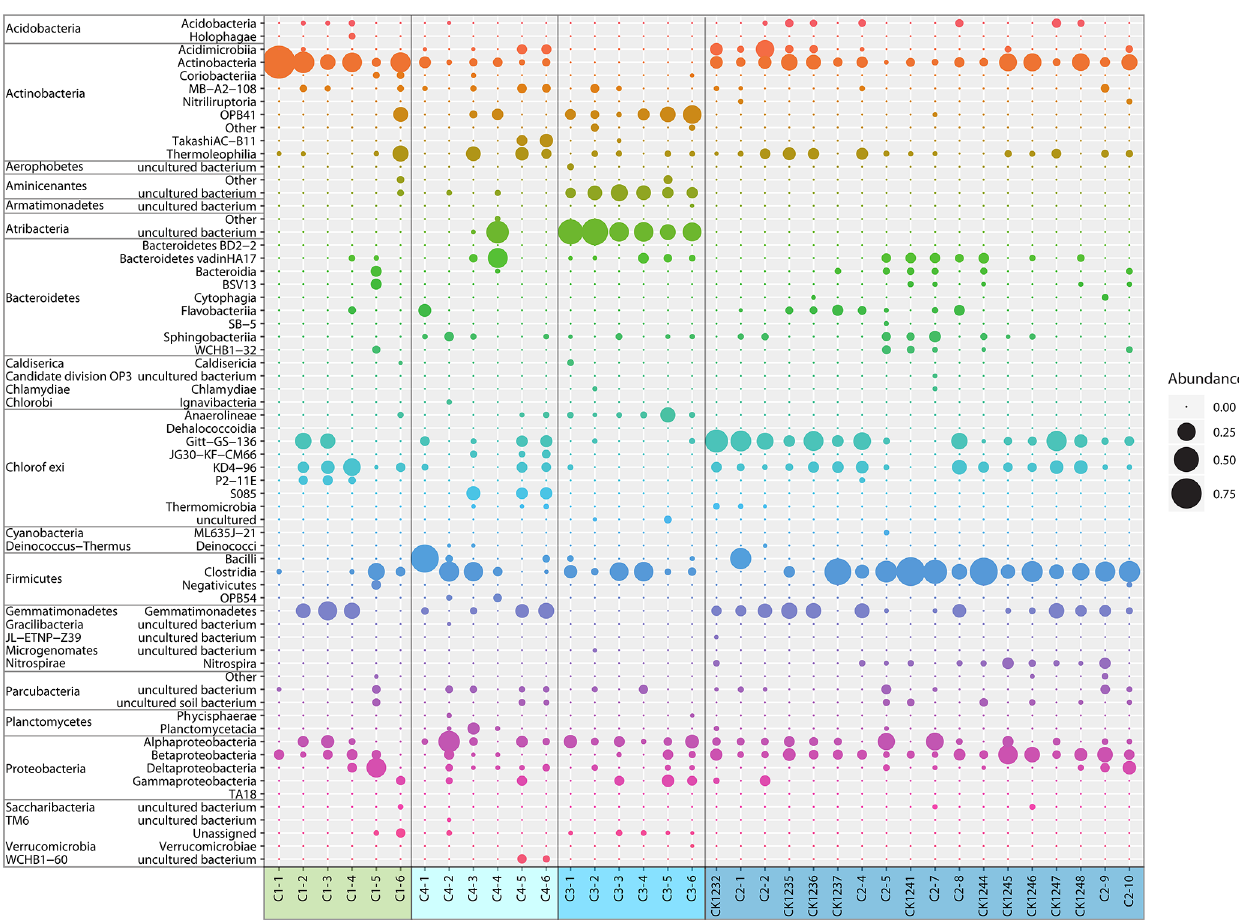
Figure 5. Relative abundance of bacterial classes from Unit II of the C1–C4 cores. Coloured boxes and the sample names below indicate the particular core. Sample names were explained earlier. Bubbles represent the mean value of relative abundances from two technical